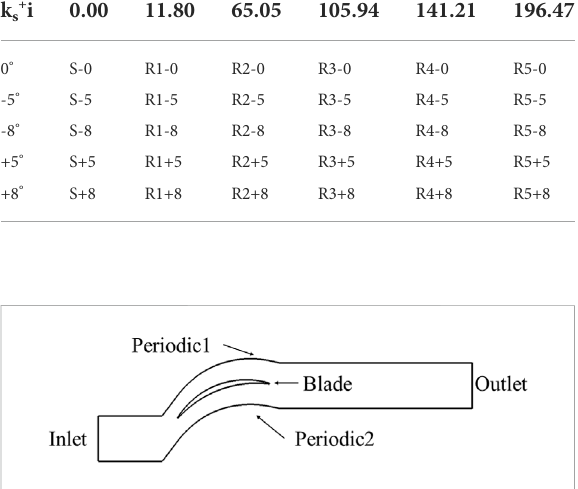
FIGURE 4 Geometrical cascade